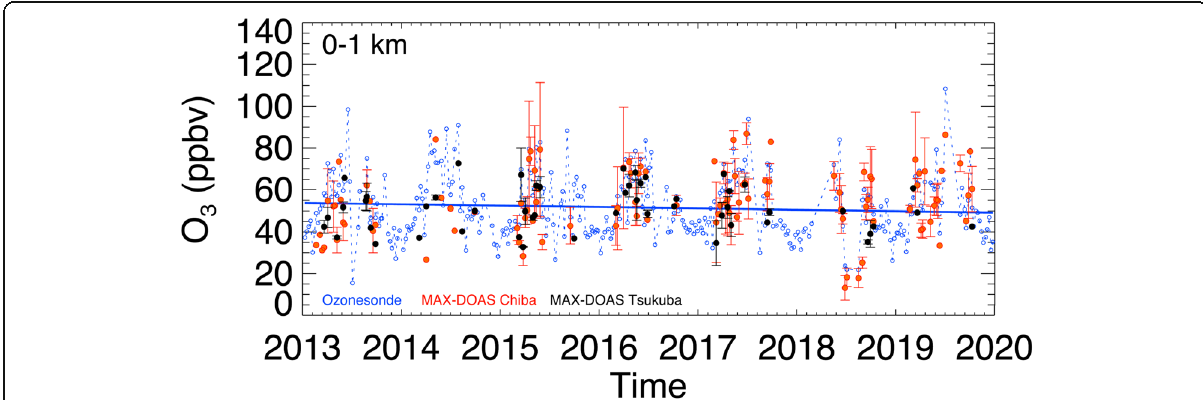
Fig. 2 Time series of O 3 concentrations for the 0 – 1 km layer measured by ozonesondes launched at Tsukuba (Tateno), Japan (blue). The ozonesonde was launched around 14:30 LT once per week. The linear trend is shown by the blue line. Mean O 3 concentrations for 13:00 – 15:00 LT retrieved from MAX-DOAS observations at Chiba and Tsukuba are shown daily in red and black, respectively. For clarity, MAX-DOAS data are shown only for the days when ozonesonde data were available. Error bars represent standard deviations within 13:00 – 15:00 LT (plus spatial variabilities in four different azimuth directions for